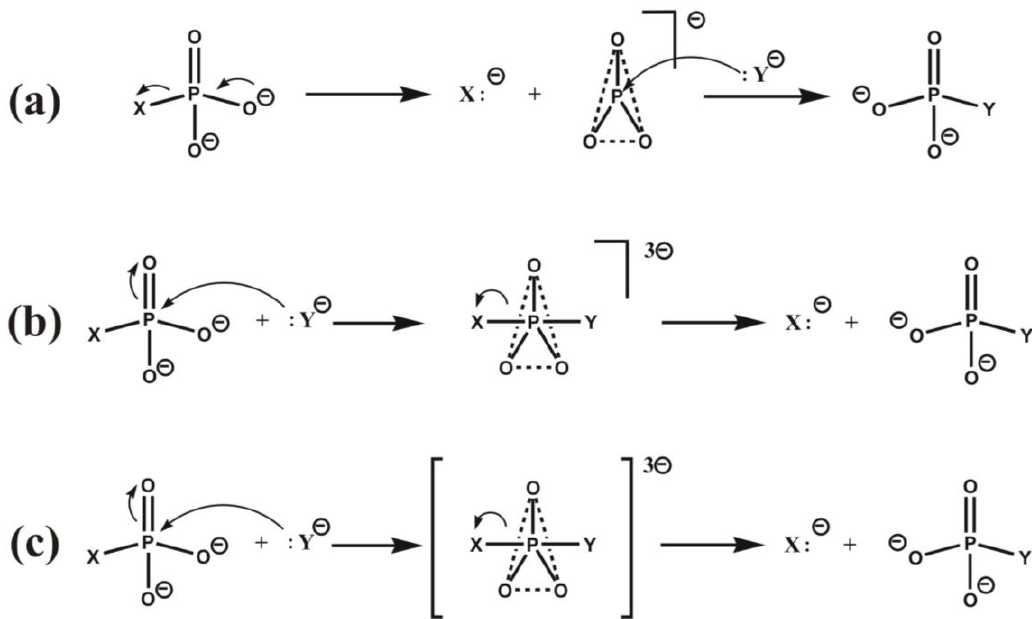
Figure 5. Reaction paths for phosphoryl transfer reactions. ( a ) Dissociative (top), ( b ) associative (middle), ( c ) S 2-type (bottom) mechanism. Square brackets represent the N transition